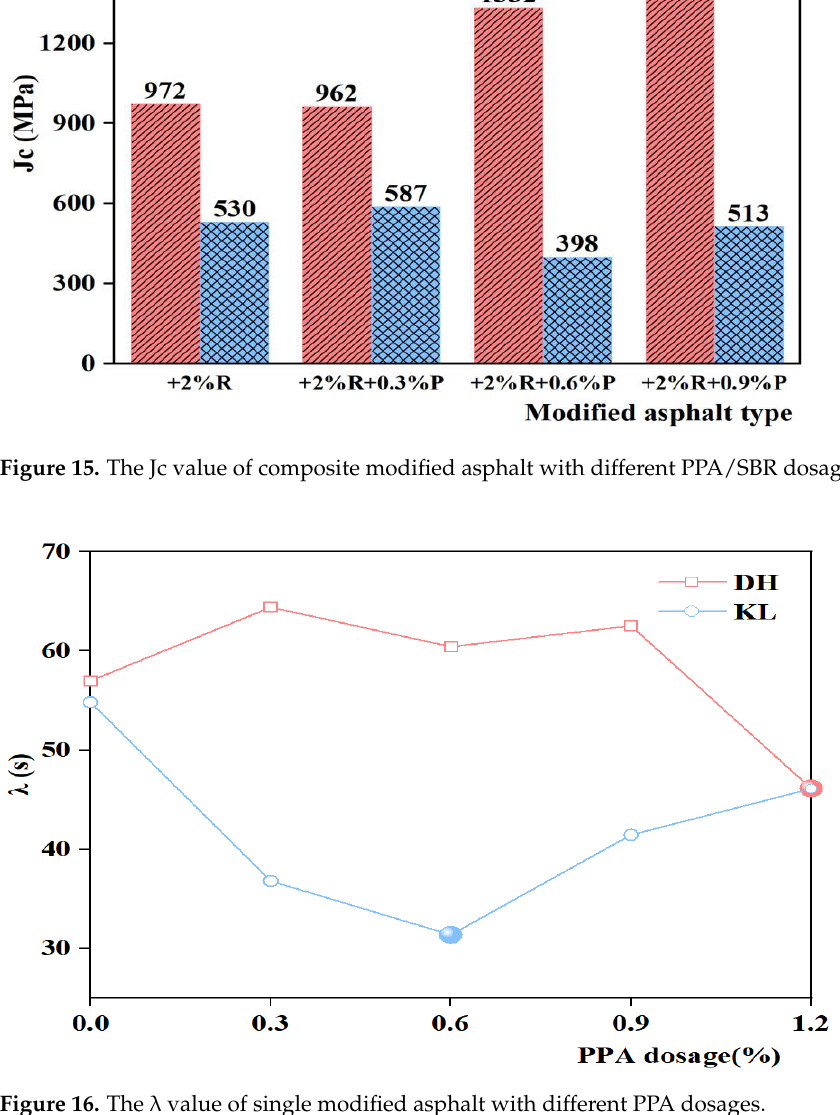
Figure 16. The λ value of single modified asphalt with different PPA dosages.